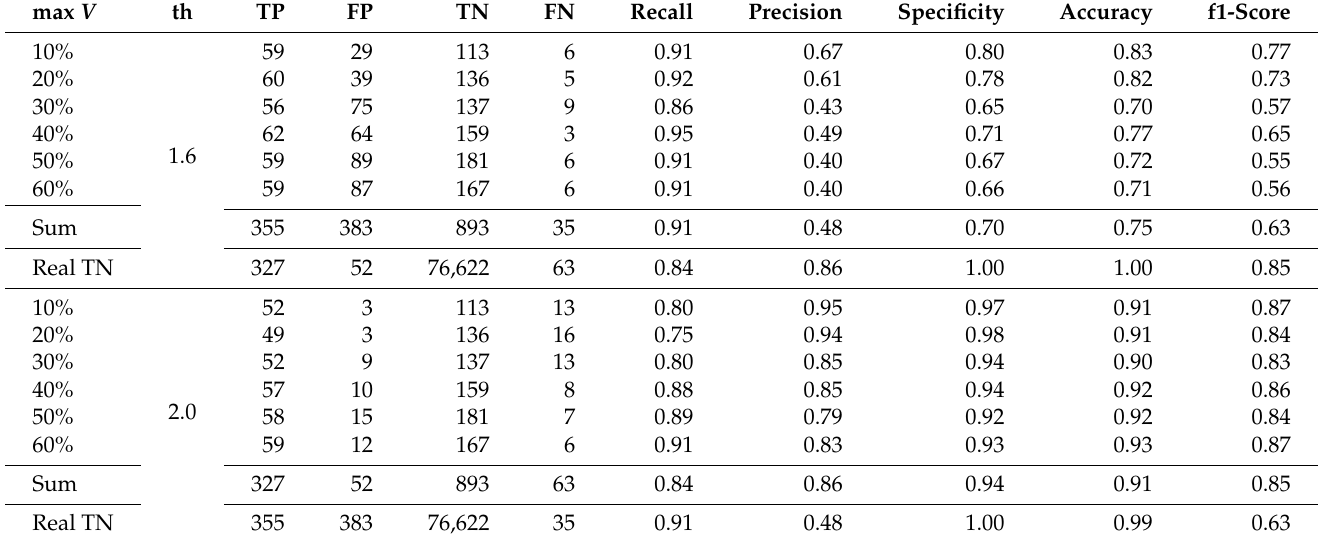
Table 3. Confusion matrix when predicting collisions on the external dataset with the optimal method of collision detection at two sub-optimal current thresholds (1.6 and 2.0 [A]), where max V is the maximum programmed speed of each joint, th is the threshold, TP is true positive, FP is false positive, TN is true negative and FN is false negative (all values have been rounded to two decimal